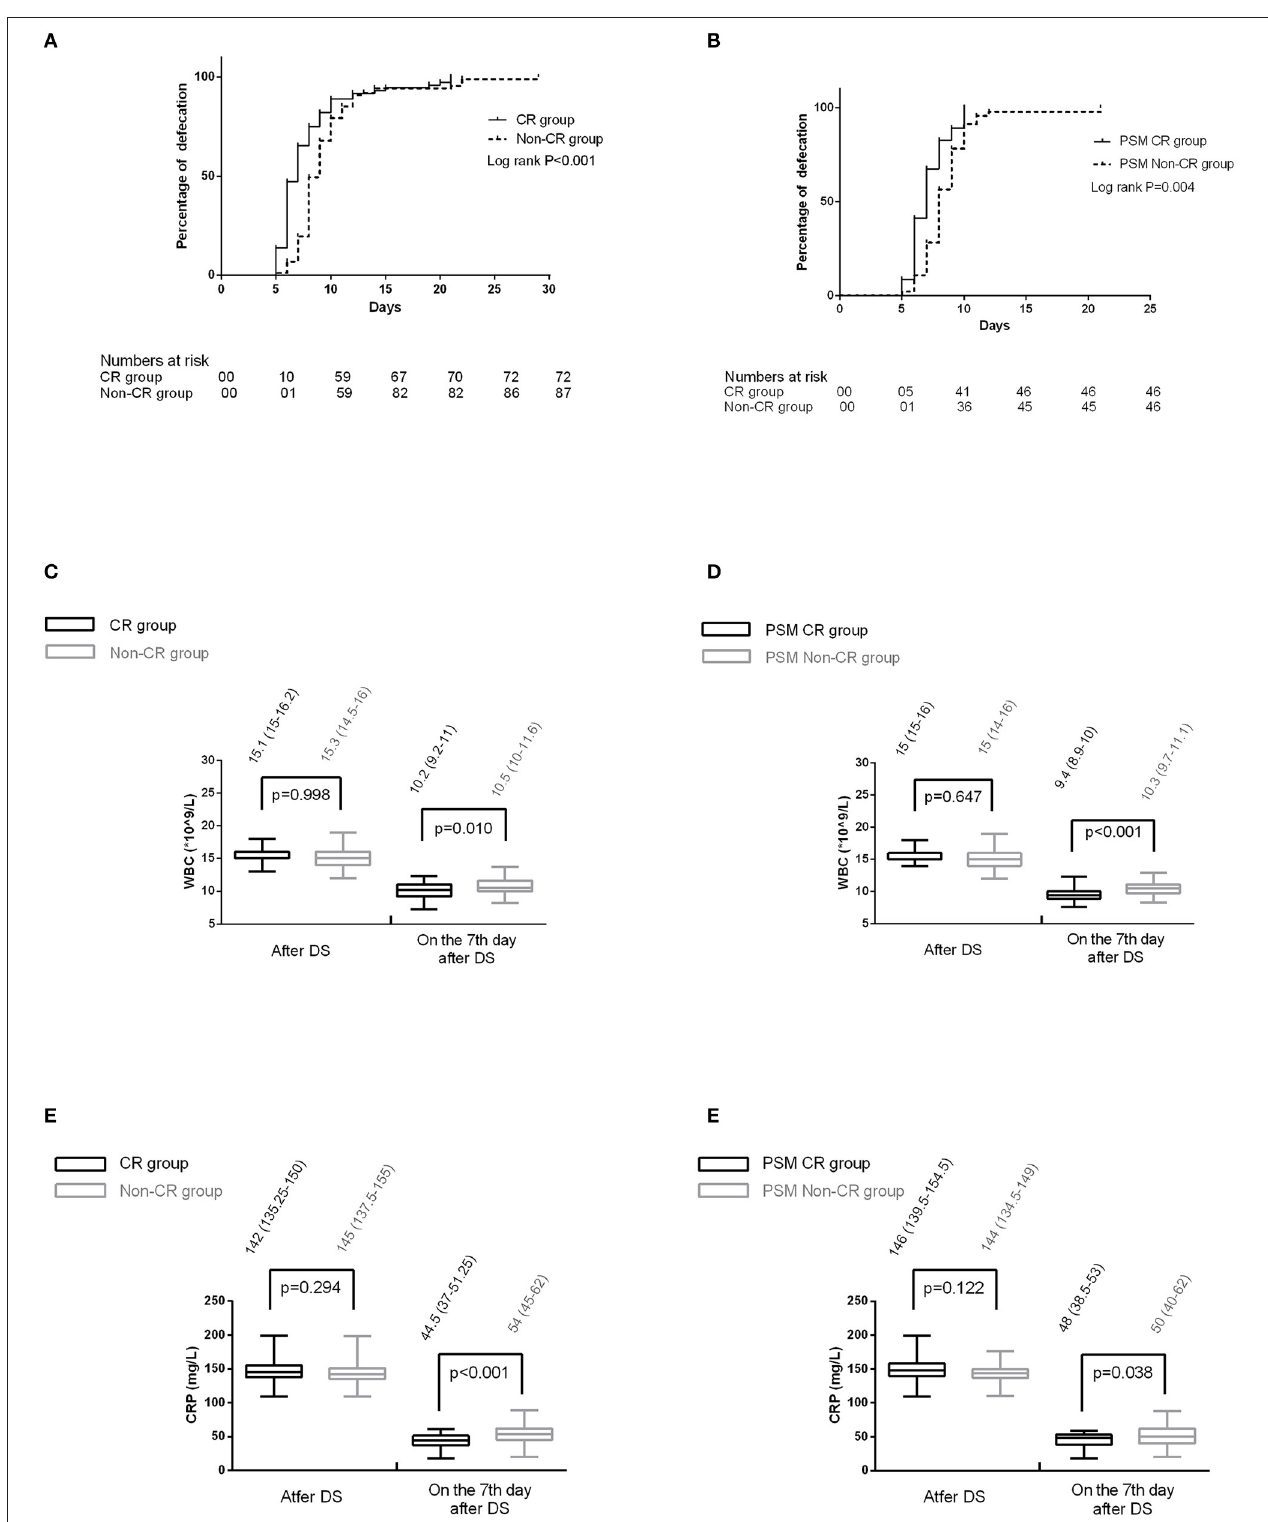
FIGURE 2 | (A) The defecation time between the two groups before propensity score-matching (PSM); (B) the defecation time between the two groups after PSM; (C) the comparison of white blood cell (WBC) between the two groups before PSM. (D) the comparison of C-reactive protein (CRP) between the two groups before PSM. (E) The comparison of WBC between the two groups after PSM. (F) The comparison of CRP between the two groups after PSM.